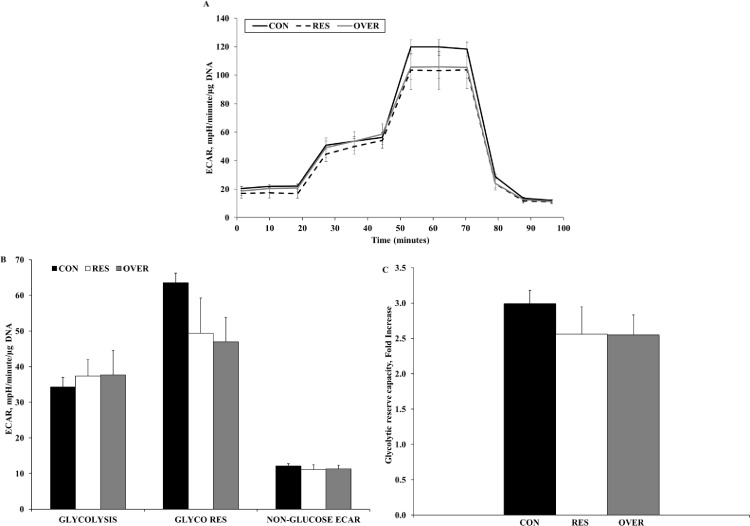
Glycolysis Stress Assay for MSC.Mesenchymal stem cells were obtained from the offspring of control-fed (CON, n = 6), restricted-fed (RES, n = 6), and over-fed (OVER, n = 5) ewes at 1 day of age. Data are presented as mean ± standard error. (A) Extracellular Acidification Rate (ECAR), an indication of glycolysis, was measured when MSC were subsequently exposed to glucose, oligomycin, and 2-deoxyglucose. (B) Calculation of basal glycolysis (GLYCOLYSIS), glycolytic reserve (GLYCO RES), and non-glucose-derived ECAR (NON-GLUCOSE ECAR) of MSC presented as mean ± standard error. (C) Glycolytic Reserve Capacity (GLYCO RES CAP) represented as fold increase of MSC. Data are presented as mean ± standard error.